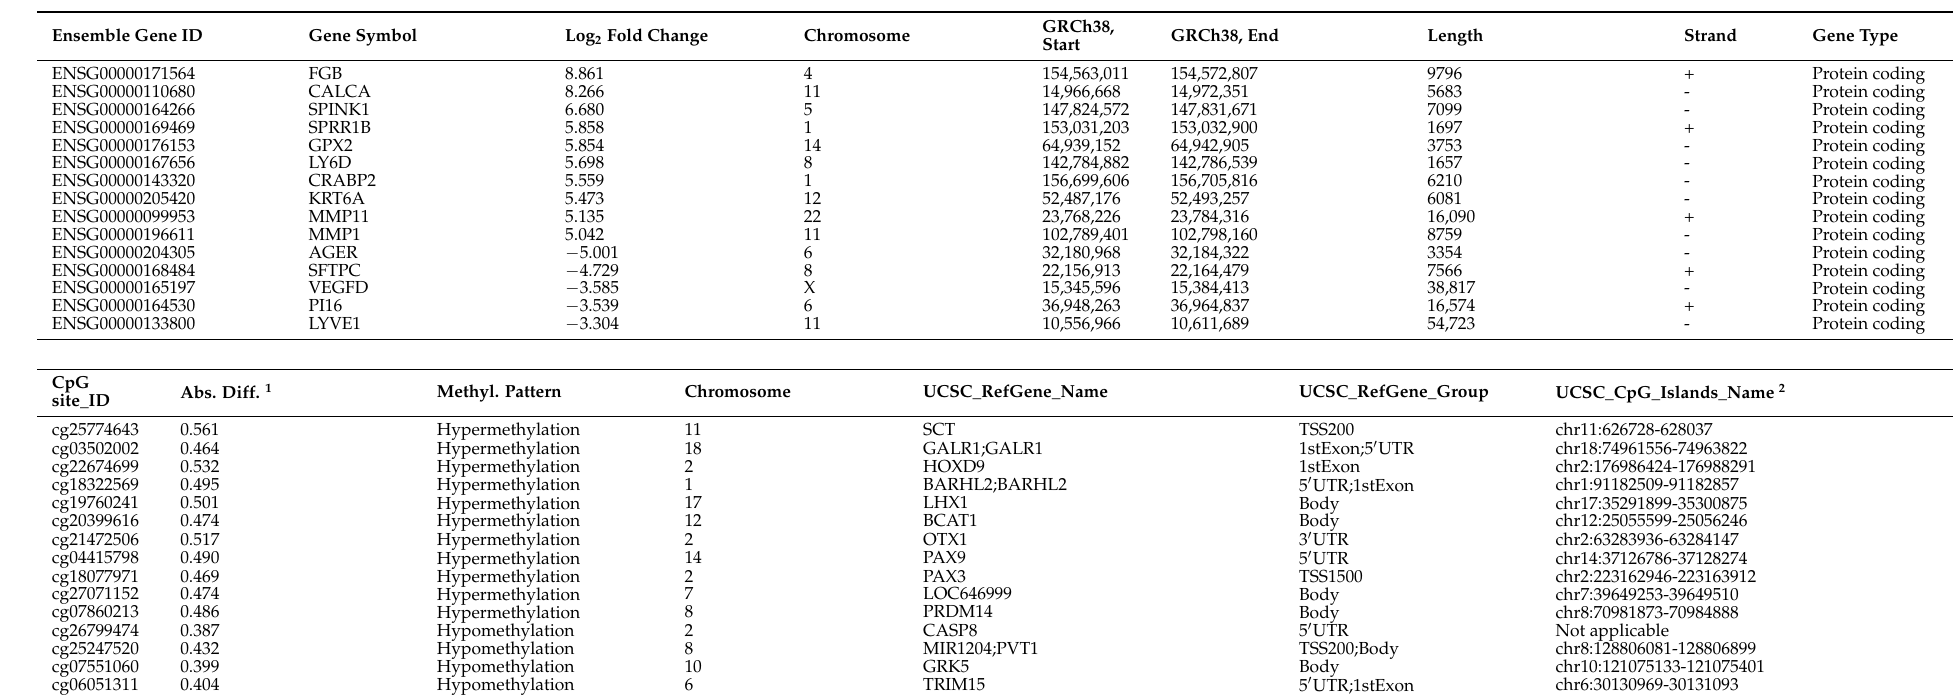
Table 3. Major RNA sequencing and DNA methylation features for NSCLC